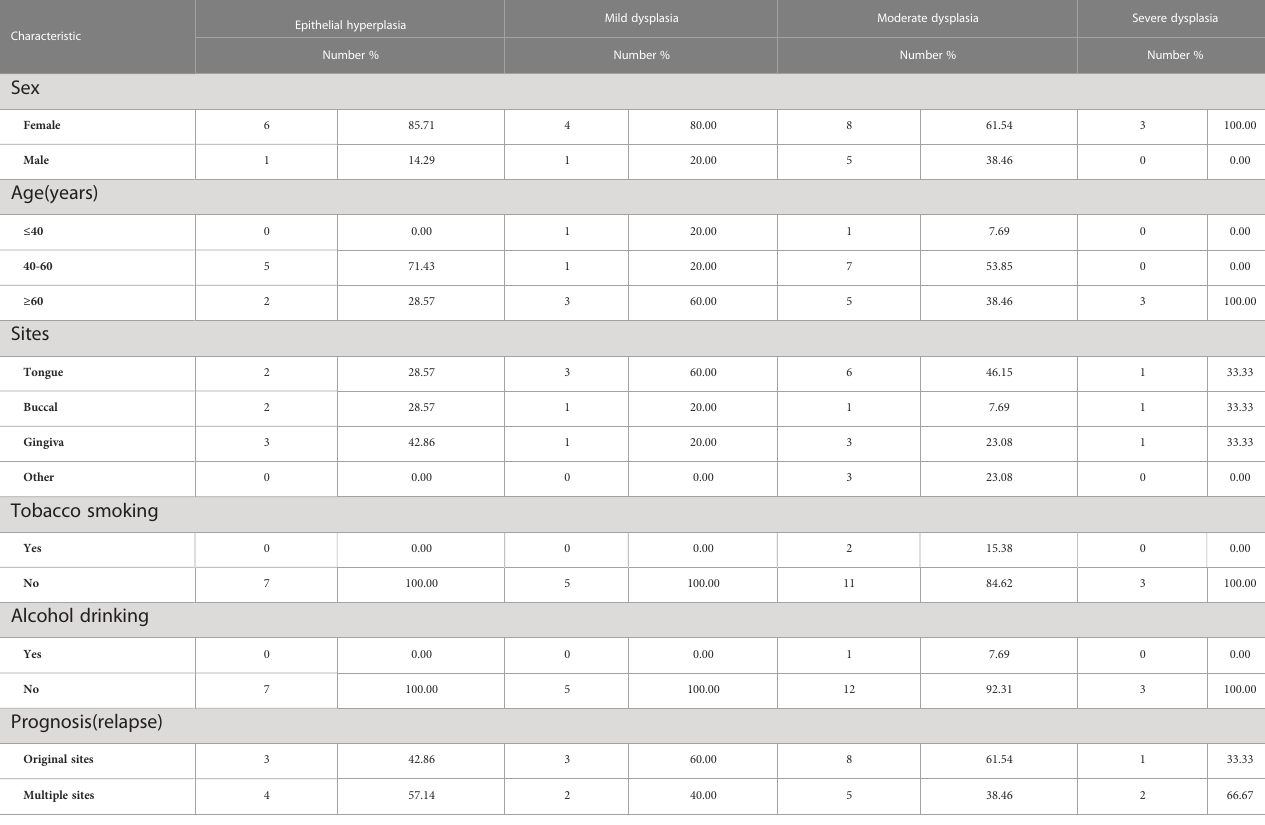
TABLE 1 Baseline characteristics of the patients in advanced group.